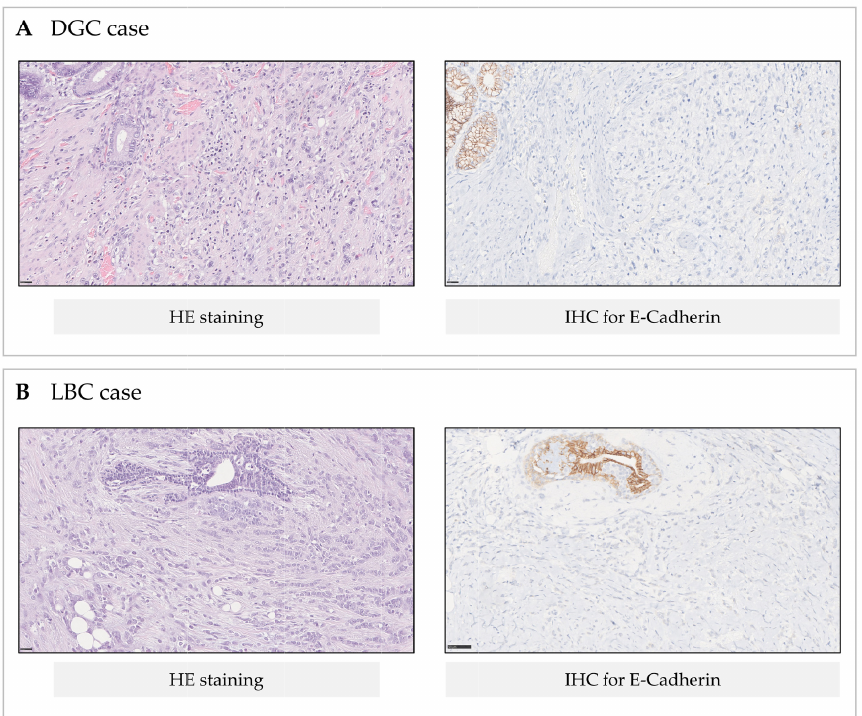
Figure 3. HE (haematoxylin and eosin) and IHC (immunohistochemistry) staining for DGC (F1 carrier) and LBC (F2 carrier) tumours from CDH1 c.1901C>T variant carriers. ( A ) Poorly cohesive (diffuse) gastric cancer composed by pleomorphic and spindle cells infiltrating the submucosa. Note the presence of residual gastric glands (top right of the image). E-cadherin IHC shows loss of E-cadherin expression in tumour cells and preserved membranous expression in adjacent non- neoplastic epithelium. ( B ) Classic lobular breast cancer composed by uniform cells lacking cohesion, dispersed, and arranged in single-file linear cords. E-cadherin IHC shows loss of E-cadherin ex- pression in tumour cells, while normal membranous expression is retained in non-neoplastic ducts (upper part of the